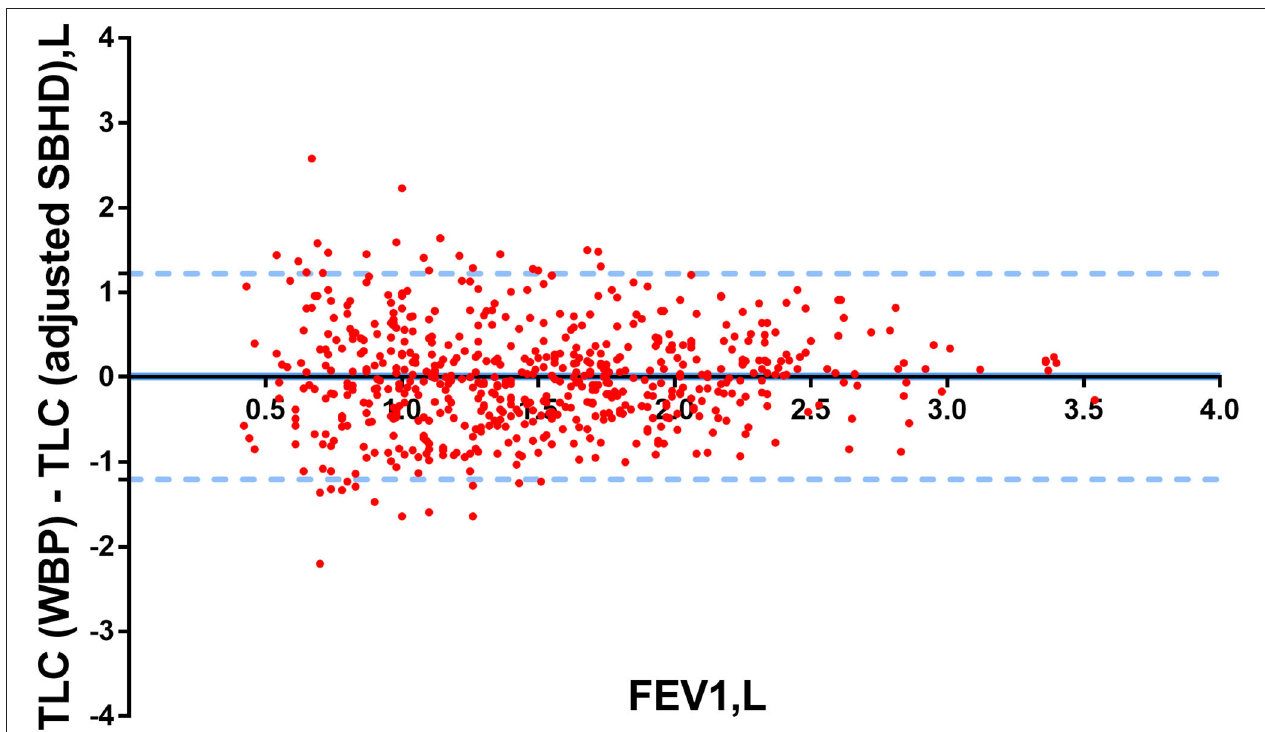
FIGURE 3 | Bland–Altman plots were used to determine the differences in TLC (WBP) and TLC (adjusted SBHD) in patients. Y-axis: the differences between TLC (WBP) and TLC (adjusted SBHD), X-axis: FEV1 (L).The limits of agreement were calculated as ± 1.96 SDs of the